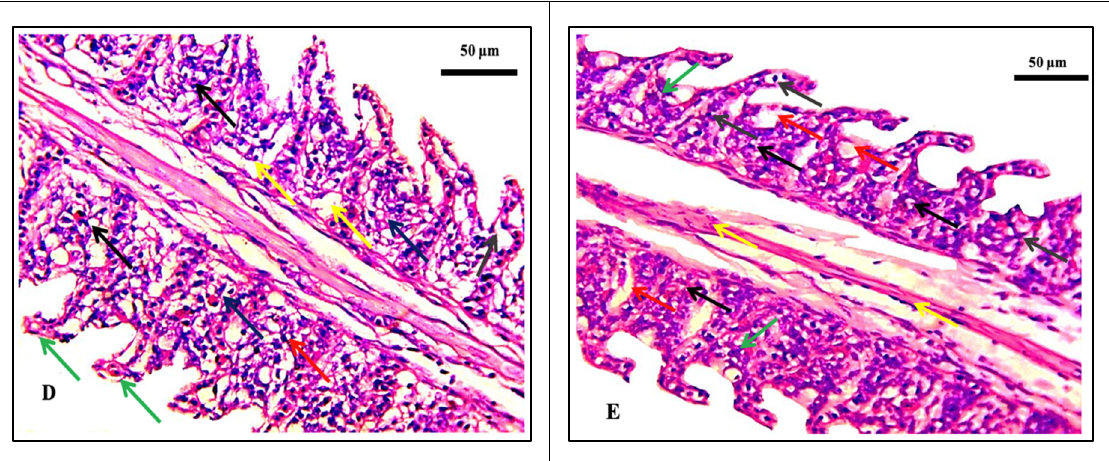
Figure 4. Photomicrographs of the gills of Nile tilapia, O. niloticus exposed to different conecntrations of Hi -ZnO-NPs. ( A ) Gills of unexposed Nile tilapia (control) showing secondary lamellae (red arrow), primary lamellae (black arrow) and epithelial cells (green arrow) ( B ) Gils of Hi -ZnO-NPs (10 ppm)-treated O. niloticus showing induced Lamellar fusion (black arrow) lamellar lifting (yellow arrow), normal central venous sinus (blue arrow), congestion of blood vessels (brown arrow), proliferation of filamentar epithelium (red arrow). ( C ) Gils of Hi -ZnO-NPs (20 ppm)-treated O. niloticus demonstrating Hyperplasia (black arrow), necrosis (green arrow), lamellar epithelium lifting (blue arrow), vasodilatation (yellow arrow) and congestion of blood vessels (red arrow). ( D ) Gils of Hi -ZnO-NPs (40 ppm)-treated O. niloticus showing proliferation (black arrow), that in some instances conduced to lamellar fusion (purple arrow), edema (yellow arrow), Aneurisms in the apical region of the lamellar vascular axis (green arrow), epithelium lifting (brown arrow) and presence of some necrotic cells (red arrow). ( E ) 80 ppm Hi -ZnO-NPs treatment showing gils with hyperplasia (green arrow), edema (red arrow), extreme dilation of the central venous (yellow arrow), proliferation of filamentar epithelium (black arrow) and necrotic cells in the primary secondary lamella (brown arrow). Stain H&E. Bar = 50 µm. Table 6. Histopathological lesions recorded on the liver Nile tilapia , O. niloticus exposed